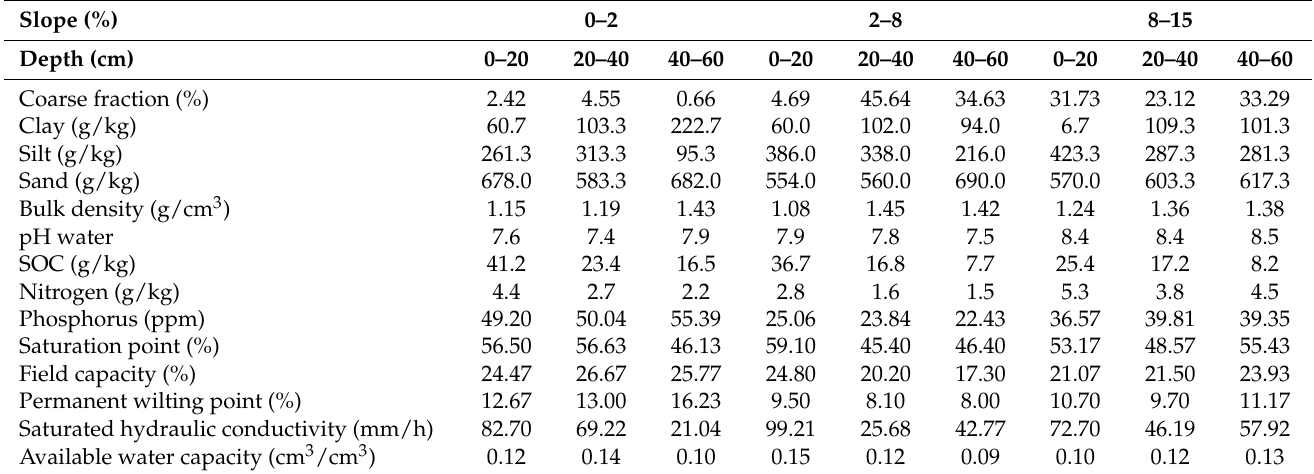
Table 1. Soil physical and chemical properties at the experimental sites along the slope gradient in the Ruzizi Plain, eastern DRC.